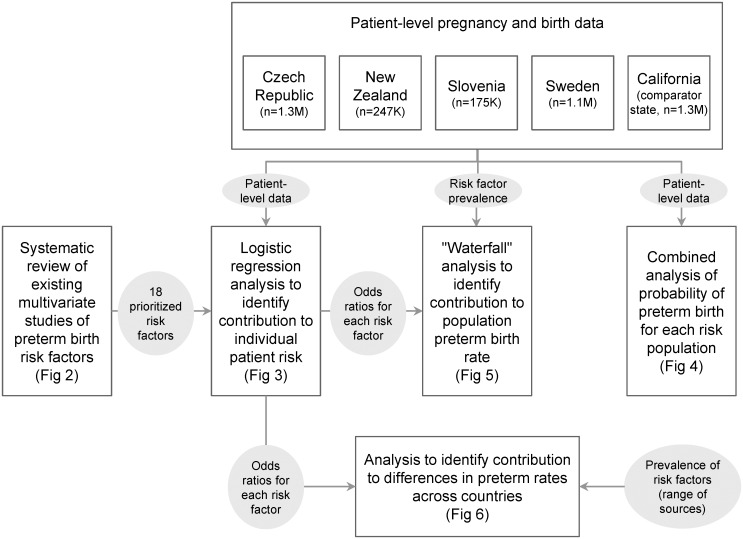
Overview of analytic approach.The four country datasets (Czech Republic, New Zealand, Slovenia, Sweden) and the U.S. comparator state (California) are indicated at the top of the figure along with the number of births included in the analysis from each. Each of the five core analyses are represented in the boxes below, and the relationship between analyses is represented by arrows.